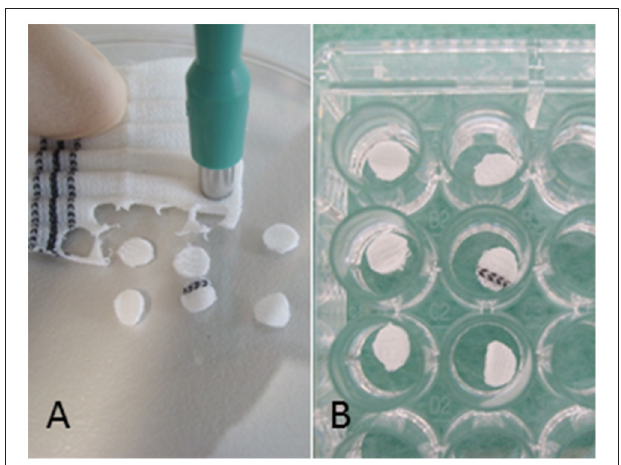
FIGURE 1 | Experiment set-up: (A) Vascular graft material was dissected with biopsy punches resulting in a standardized surface area of 0.25 cm 2 and (B) placed into 96-well polystyrene (PS) cell culture